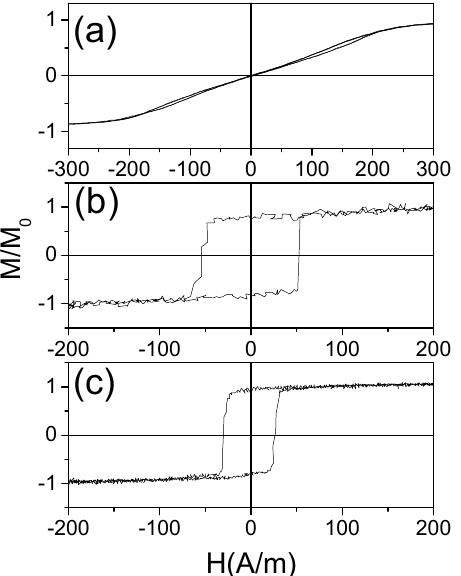
Figure 6. Hysteresis loops of as-prepared ( a ); annealed at T ann = 300 °C for σ a = 0 MPa ( b ) and for σ a = 80 MPa ( c ) Co 69.2 Fe 4.1 B 11.8 Si 13.8 C 1.1 microwires.